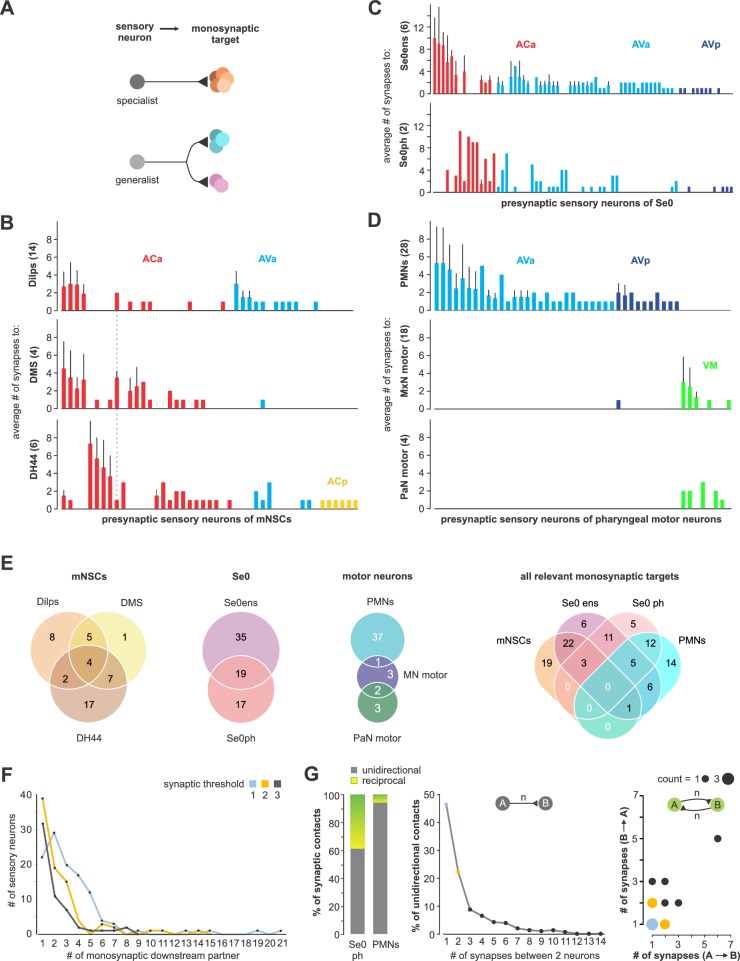
Connectivity principles of monosynaptic reflex connections.(A) Specialists target exclusively one output group. Generalists diverge onto different output groups. (B,C,D) Connectivity between presynaptic sensory neurons of mNSCs (Dilps, DMS, DH44), the Se0 Cluster (Se0ens, Se0ph) and feeding motor neurons (PMNs, MxN-, PaN motor neurons). Each column across the graphs represents a presynaptic partner of the output neurons. Whiskers represent standard deviation. (E) Venn diagrams show overlap and difference between presynaptic sensory neurons of the different target groups. (F) Amount of monosynaptic downstream partners per sensory neuron, using a synaptic threshold of 1–3 synapses. (G) Percentage of output neurons targeted in a hierarchical or reciprocal manner. Only Se0ph (2 cells) and a few pharyngeal motor neurons (7 cells) show presynaptic sites. Therefore, reciprocal contacts only occur in these cases (left panel). Percentage of all unidirectional connections from all sensory neurons to a given output target, relative to the number of synapses between two neurons (middle panel). Amount of reciprocal connection combinations from all sensory neurons to a given output target, or vice versa (right panel).